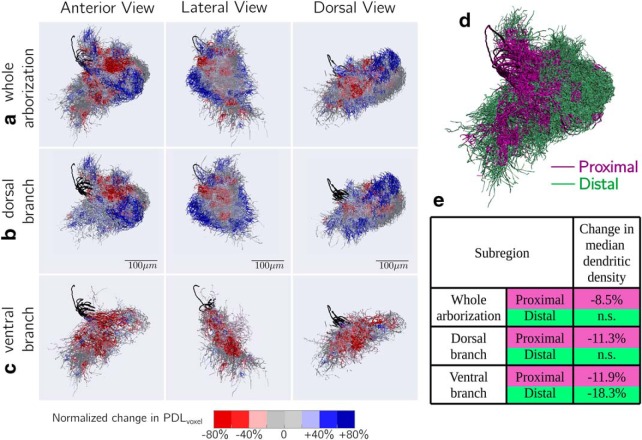
Region-dependent changes in dendritic density. All 12 DL-Int-1 morphologies visualized together after co-alignment, highlighting regions that show significant differences in PDLvoxel during maturation. a, WA, b, DB, and c, VB. A voxel was highlighted if ART two-way ANOVA indicated that maturation had a significant effect on PDLvoxel independent of registration parameters. The dendrites were colored with normalized change in PDLvoxel (see Materials and Methods, Morphological comparison using 3D voxels; for distributions, see Extended data Figure 3-1). The MBs are colored in black. d, The space containing the morphologies was divided into proximal and distal partitions based on distances along the dendritic tree of a node from the root and terminals in its subtree (for detailed 3D view for all subregions, see Extended data Figure 3-2). e, Changes in median PDLvoxel in proximal and distal partitions of each subregion. “n.s.” indicates that maturation did not have a significant effect on PDLvoxel independent of registration parameters when tested with ART two-way ANOVA (for distributions, see Extended data Figure 3-3).